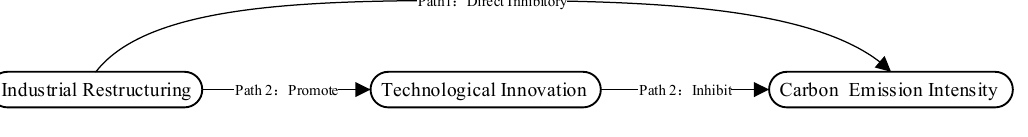
Figure 1. The research logic model .